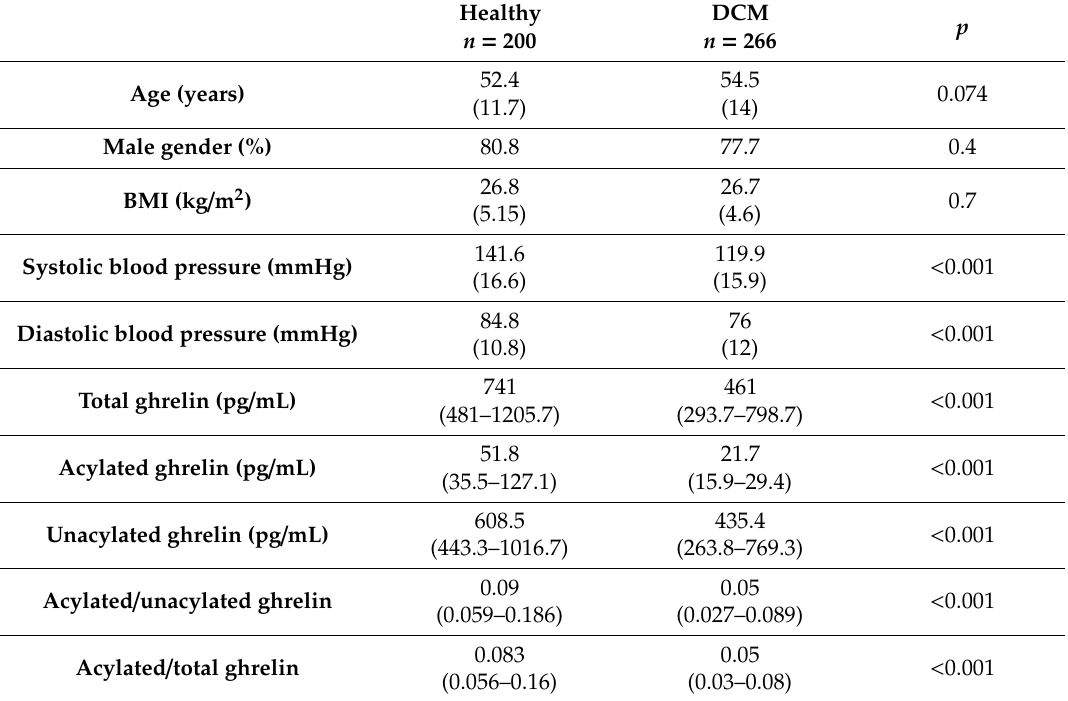
Table 1. Baseline characteristics of healthy subjects and patients a ff ected by dilated cardiomyopathy (DCM).